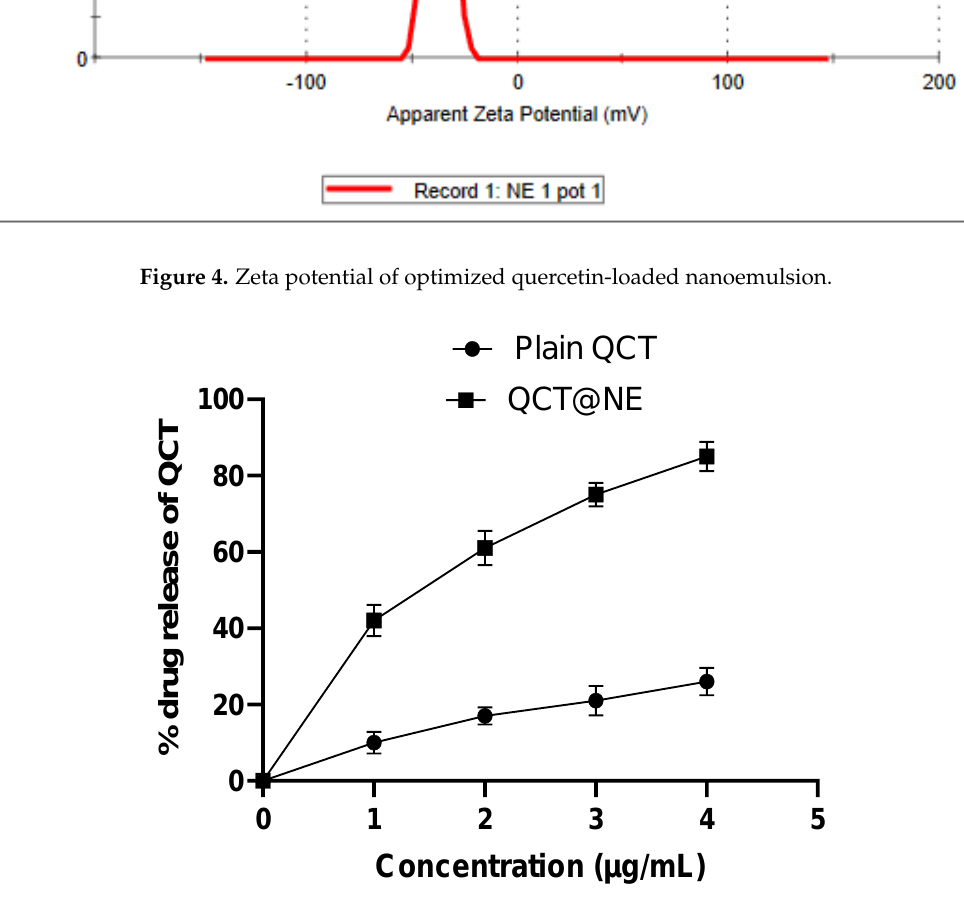
Figure 5. In vitro drug release of QCT from its plain suspension and the optimized nanoemulsion.